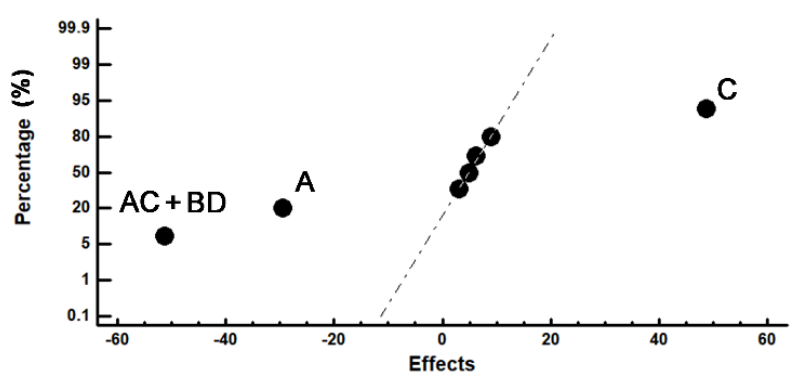
Figure 4. Representation of the standardized effects on the weight loss by abrasive wear in a test of 30 min duration, plotted on a normal probability graph. A(destabilisation temperature); B(cooling media); C(tempering temperature); D(tempering time).